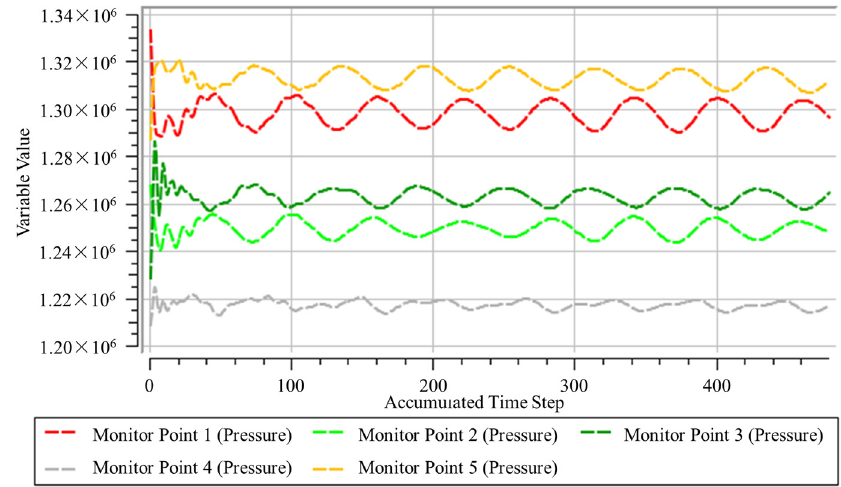
Figure 6. Convergence history of the pressure at monitoring points.